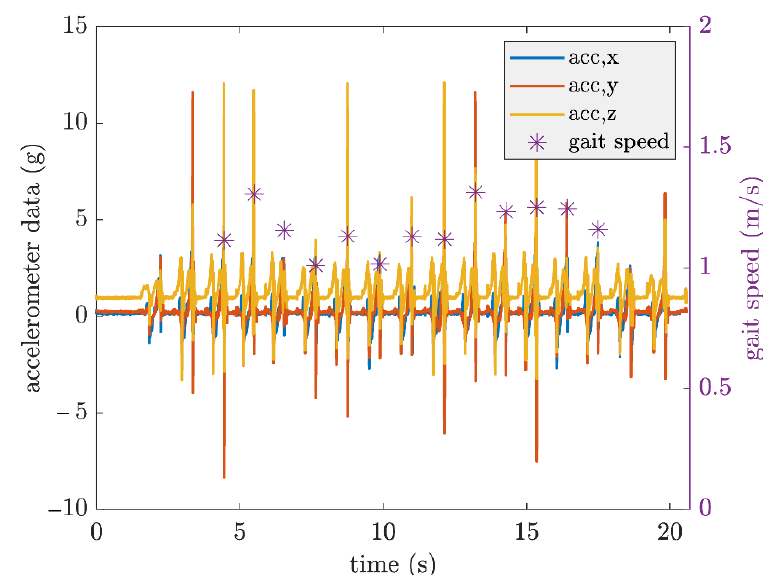
Figure 2. Example of gait speed extraction from a PD patient during straight walking at fast pace. Gait speed is given for each gait cycle of the right foot.